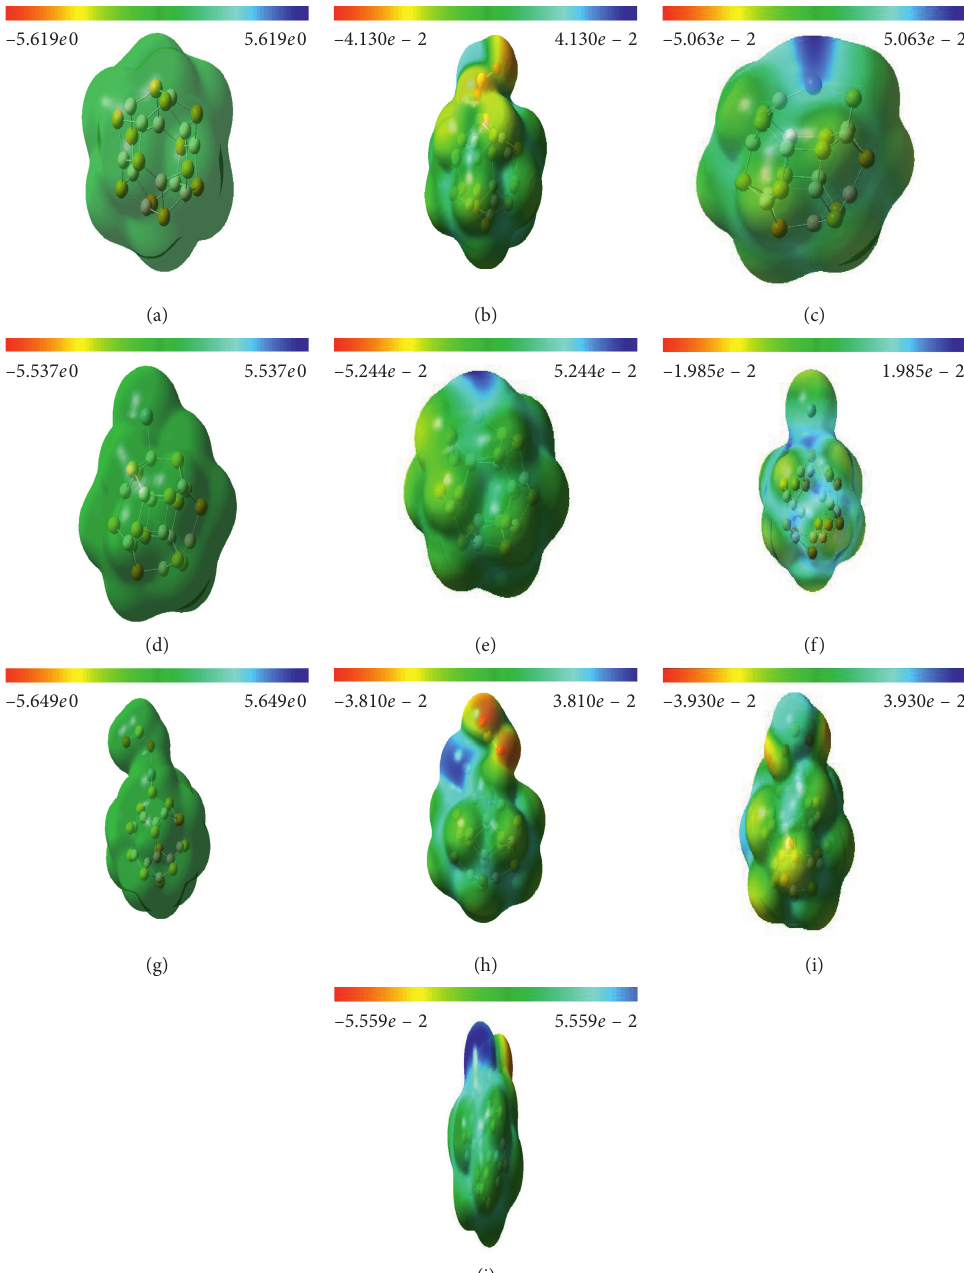
12 P 12 nanocage, (b) SO 2 -adsorbed B 12 P 12 , (c) M1, (d) M2, (e)